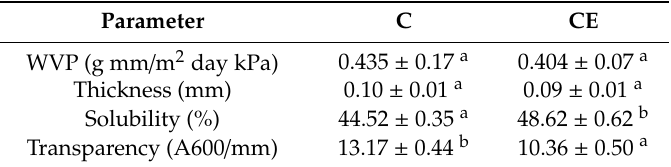
Table 1. Partial characterization of edible films.